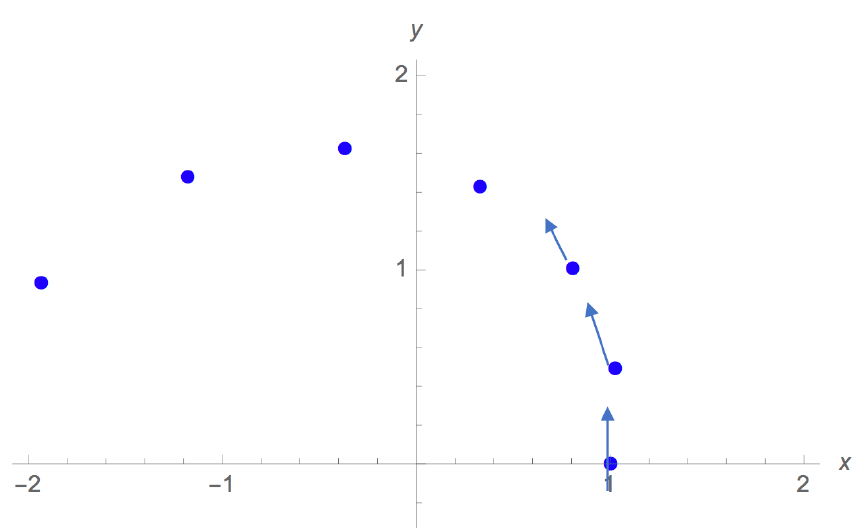
Figure 1. The top of the wave moving with time along the spiral due to the rotation. The group velocity has a tangent direction on the spiral at each point due to the stretched coordinates transformed in the manner caused by the marginal stability of the disk. The width of the wave has not been presented in this figure, just the top the wave; top view. The shape of the wave is shown in Figure 3.